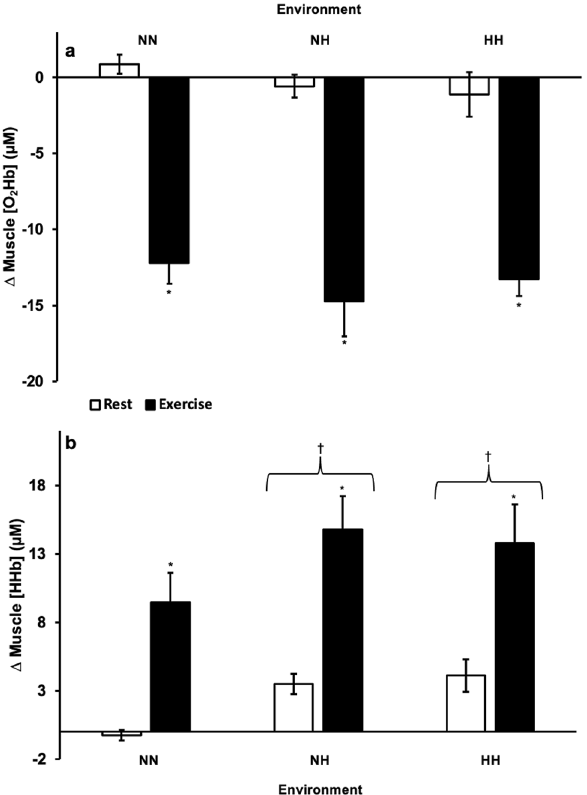
Figure 1. ( a ) Muscle oxygenated (O 2 Hb) and ( b ) deoxygenated (HHb) hemoglobin concentration change at normobaric normoxia (NN), normobaric hypoxia (NH), and hypobaric hypoxia (HH) during rest and exercise expressed relative to daily pre-environmental exposure at NN. * p < 0.05 from Rest. † p < 0.05 from NN. Data presented as means ±